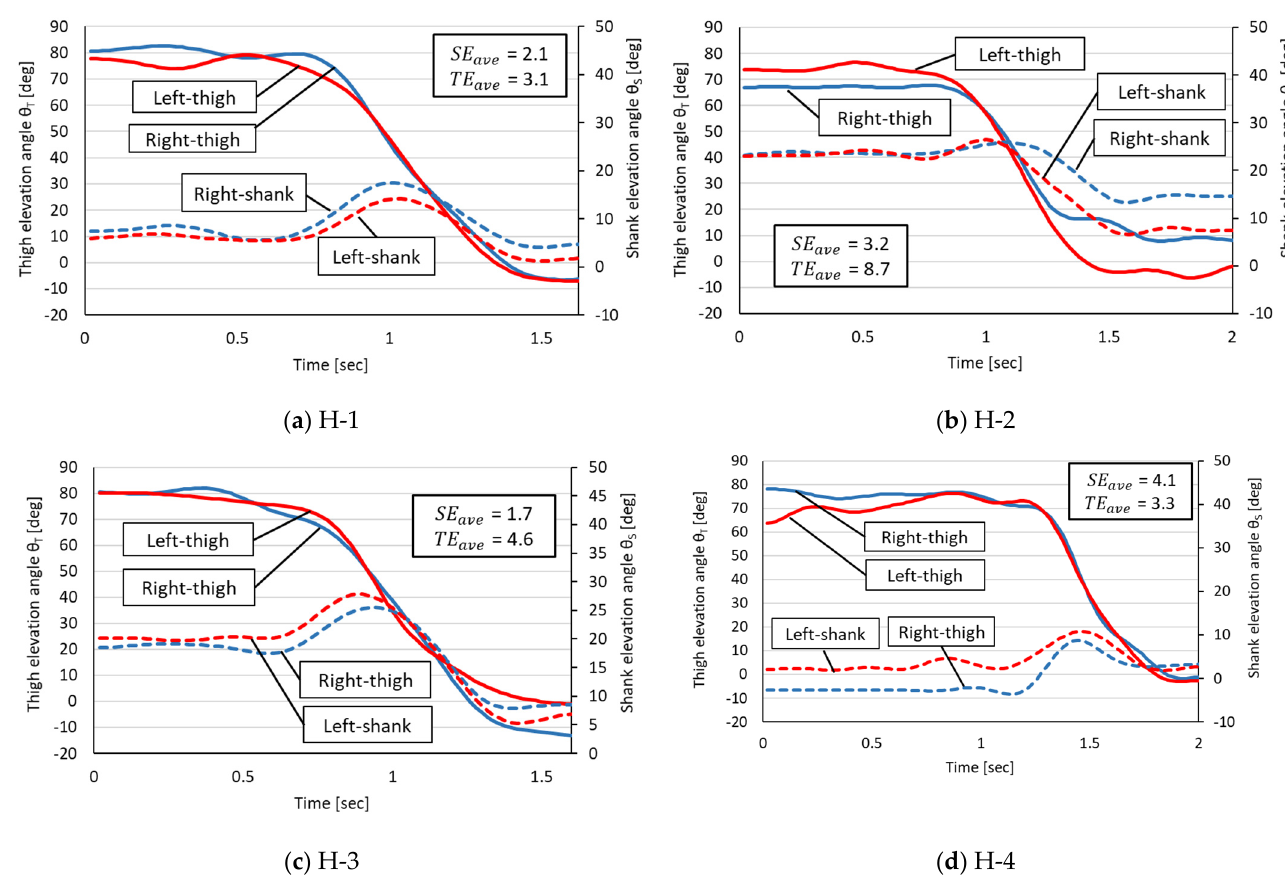
Figure 4. Measured angular changes in thigh and shank EAs in the healthy group. The horizontal axis is the STS time (in seconds) of each participant. H-1 through H-4 in the figure refer to each healthy participant in Table 1.